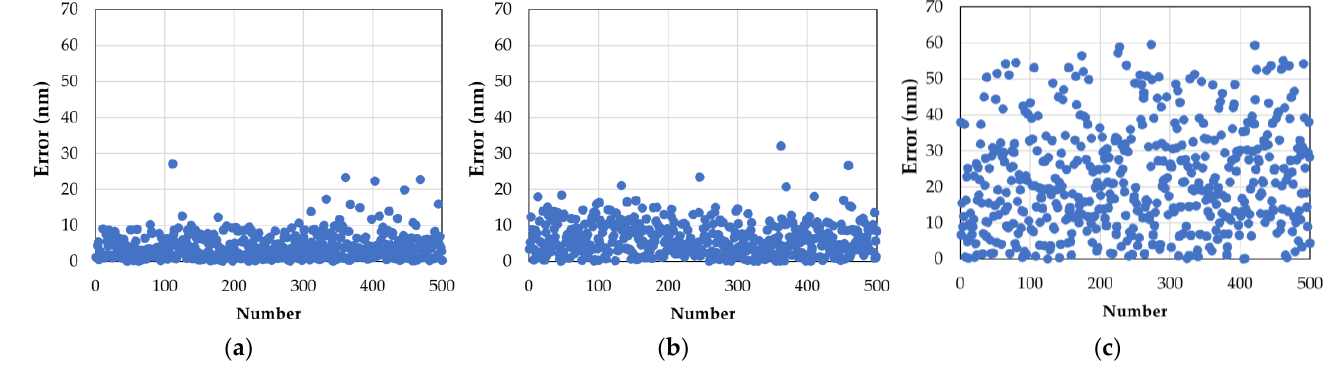
Figure 6. The testing results of the different data sets: ( a ) 500 errors were selected from the testing data set based on the DSM; ( b ) 500 errors were selected from the testing data set based on the SM; ( c ) 500 errors were selected from the testing data set based on the PM.